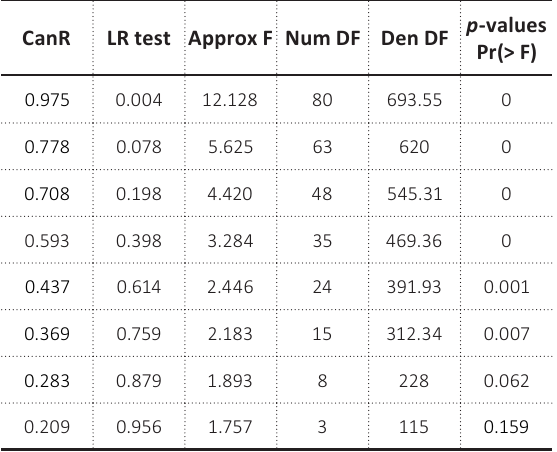
Table 2. Results of null hypothesis testing CanR